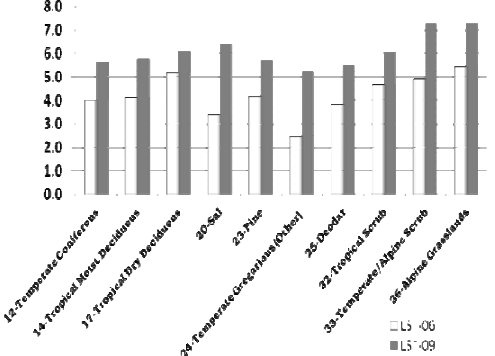
Fig.1. Land Surface Temperature differe month) of different vegetation categories i based on MODIS-LST. 2009 skin temperat more.